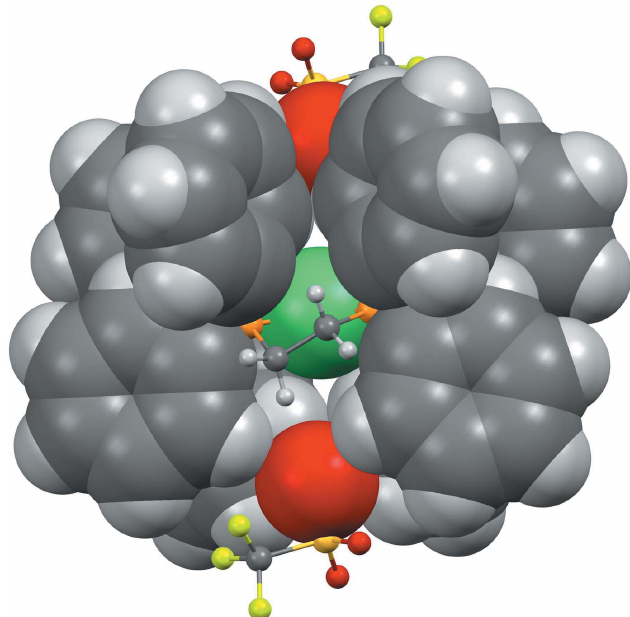
Figure 1 ORTEP rendering of 1 at 100 K with displacement ellipsoids drawn at the 50% probability level. Hydrogen atoms and the disordered parts of the anion were omitted for clarity. Atoms with the suffix A are generated by the symmetry operation (1 (cid:3) x , 1 (cid:3) y , 1 (cid:3) z ).